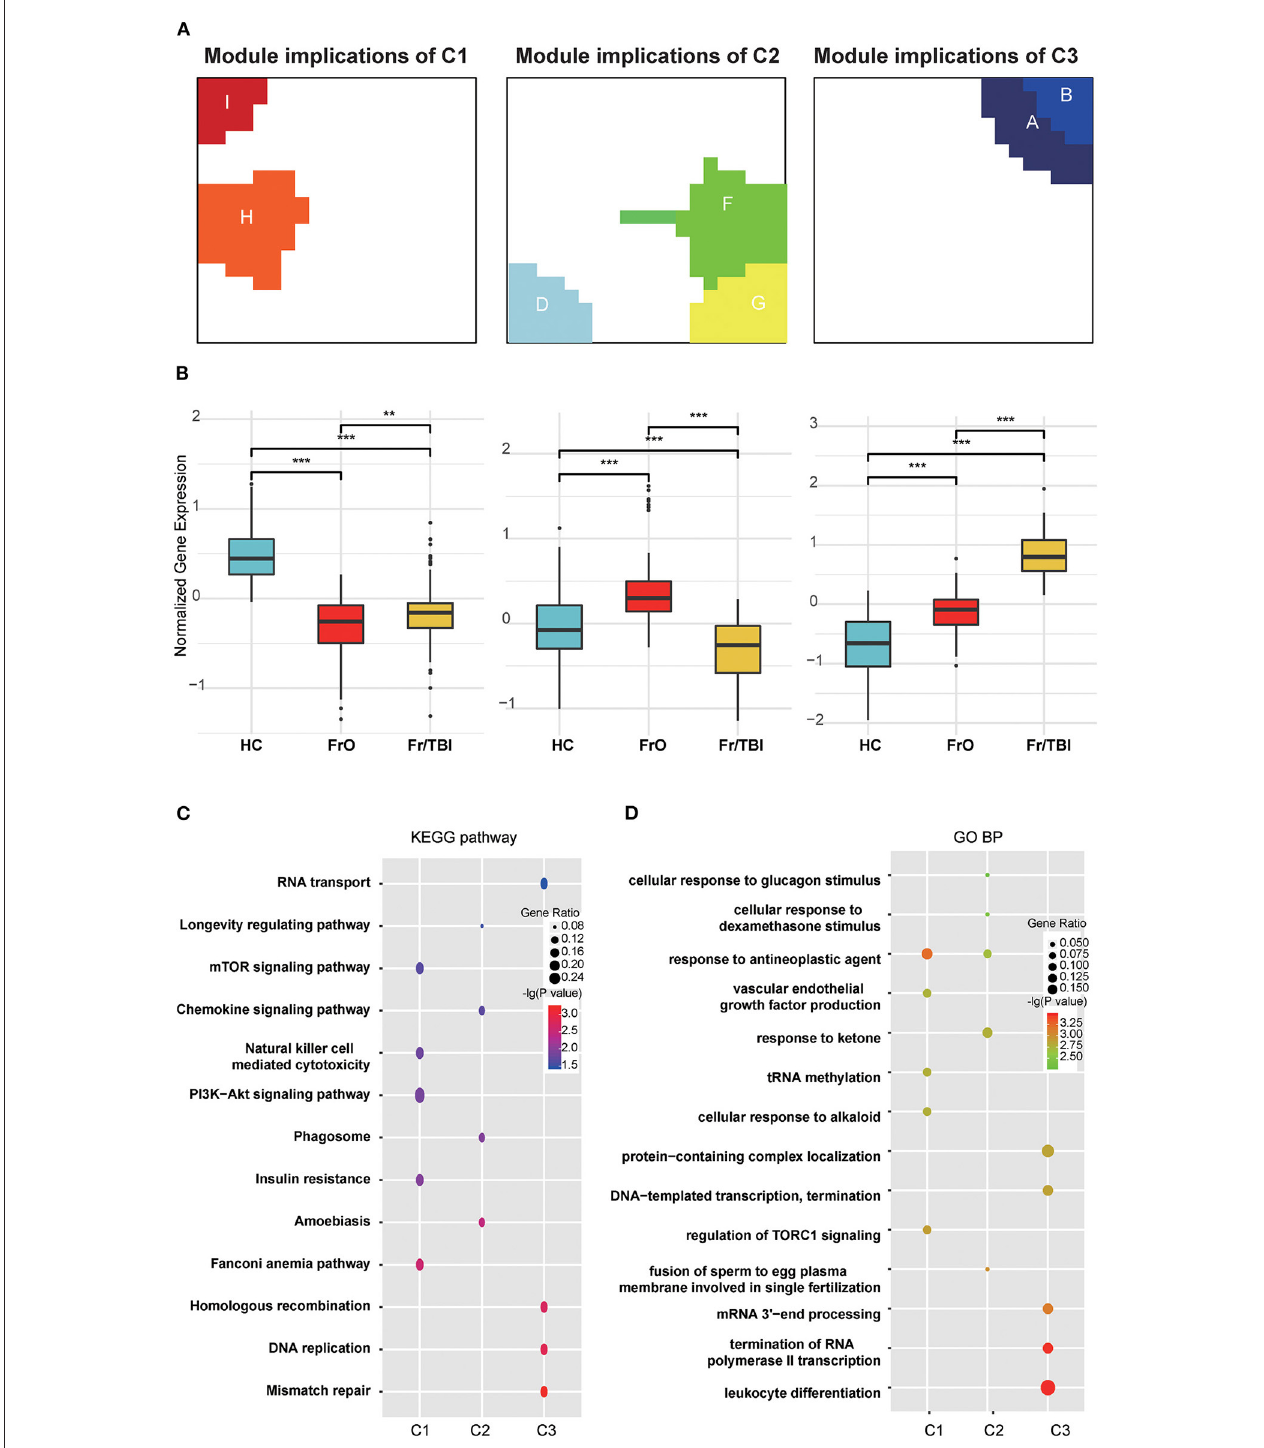
FIGURE 3 | Annotation of harvested expression modules. (A) Representative images of module implications subdivision. (B) Boxplot showed the normalized gene expressions of subdivided module implications in each group. P -values were obtained via Wilcoxon’s test. ** and *** indicate P -value < 0.01 and P -value < 0.001, respectively. (C) Kyoto Encyclopedia of Genes and Genomes (KEGG) enrichment analyses of genes from each module implication. (D) Gene Ontology (GO) biological process enrichment analyses of genes from each module implication. The vertical and horizontal axes represent the KEGG pathways and different modules, respectively. The size and the color intensity of a circle represent gene number and –log10 ( P -value), respectively.